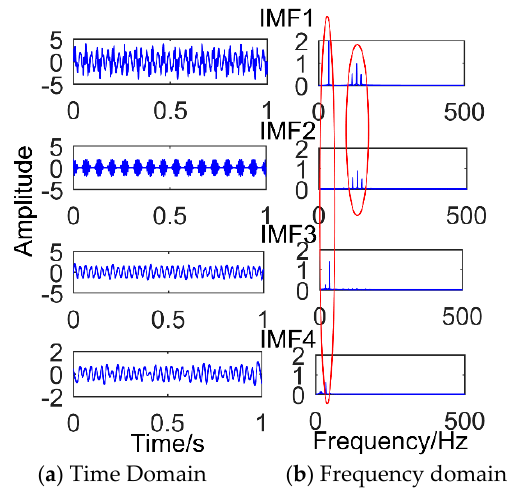
Figure 3. Results of the simulated signal decomposed by Ensemble Empirical Mode Decomposition.